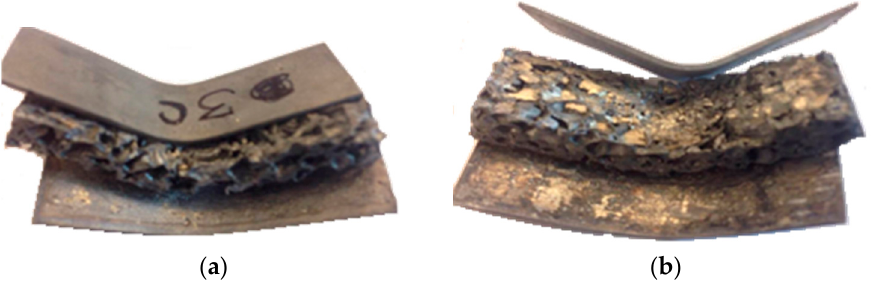
Figure 11. Representative post-three-point bending test delaminated specimens (specimen dimensions: 60 mm × 20 mm × 11.4 mm). ( a ) Brazed using Al-Cu-Mg and ( b ) brazed using Al-Si-Mg-Ti brazing alloy.